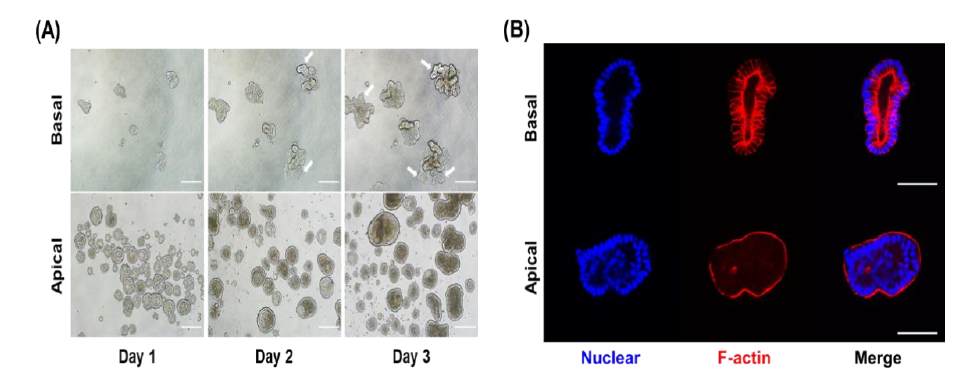
Figure 2. Comparison of morphology for basal-out and apical-out porcine small intestinal organoids. ( A ) Representative images of two types of organoids culture from day 1 to day 3 (magnification: × 100). The arrows indicate the organoid budding points. Scale bar (200 µ m). ( B ) Images of stained organoids (magnification: × 400). Nuclear and F-actin were stained by DAPI and phalloidin. The images represent switched axis between basal-out organoid and apical-out organoids. Scale bar (100 µ